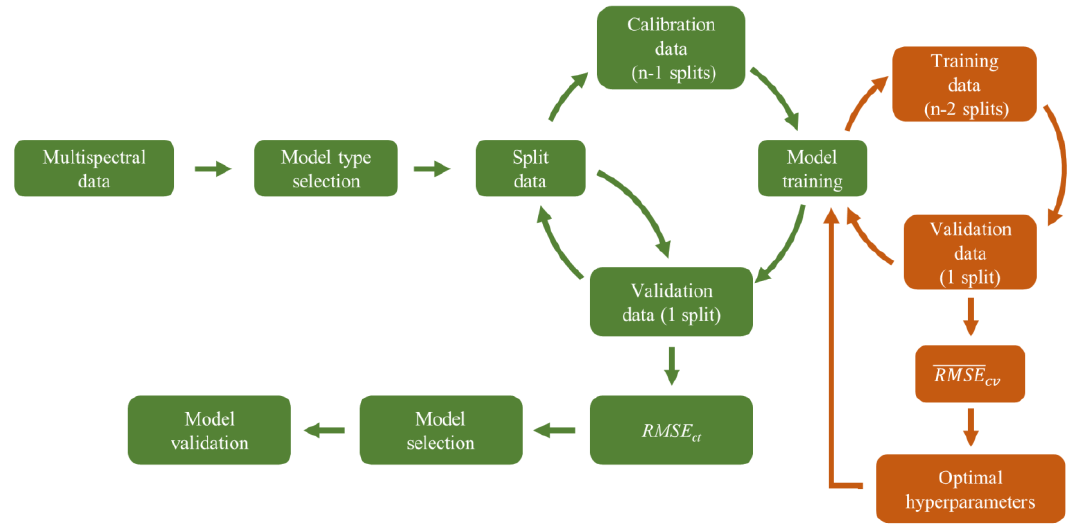
Figure 2. Workflow for model training, hyperparameter optimization and model